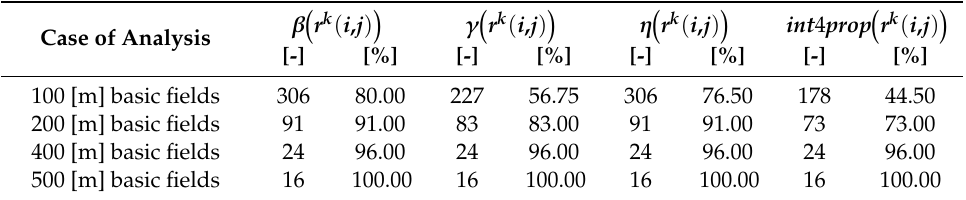
Table 3. Number and share of basic fields with the calculated value of each measure in each case of analysis.